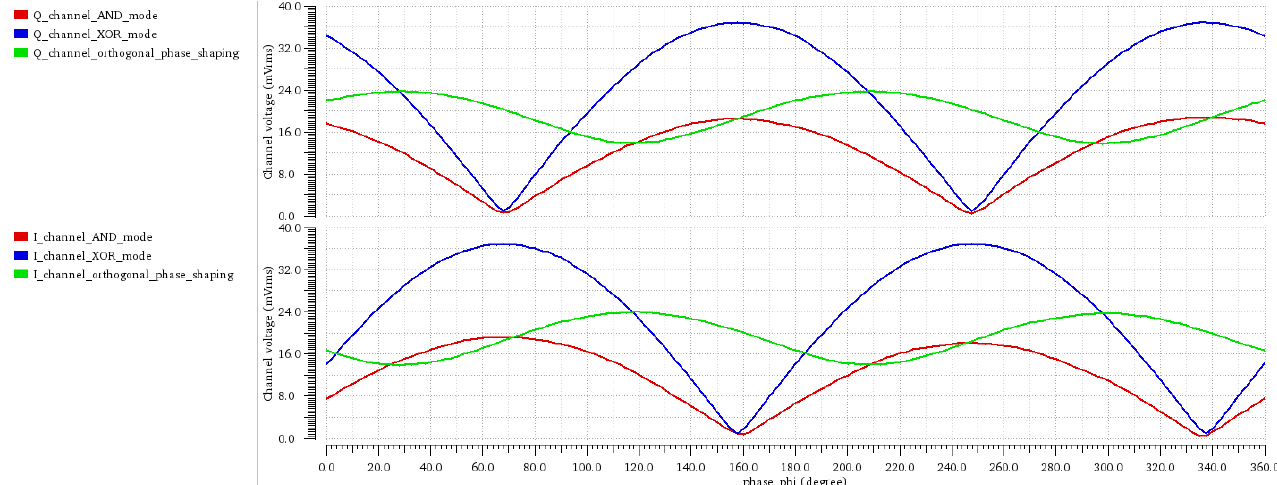
Figure 8. Reader I and Q channel rms voltage versus the tag transmission phase. The signal received by the reader is shown for three transmission modes: AND, XOR and the orthogonal phase shaping. The orthogonal phase shaping guarantees sufficiently large signal on the reader I and Q channels when compared to the other two modes.